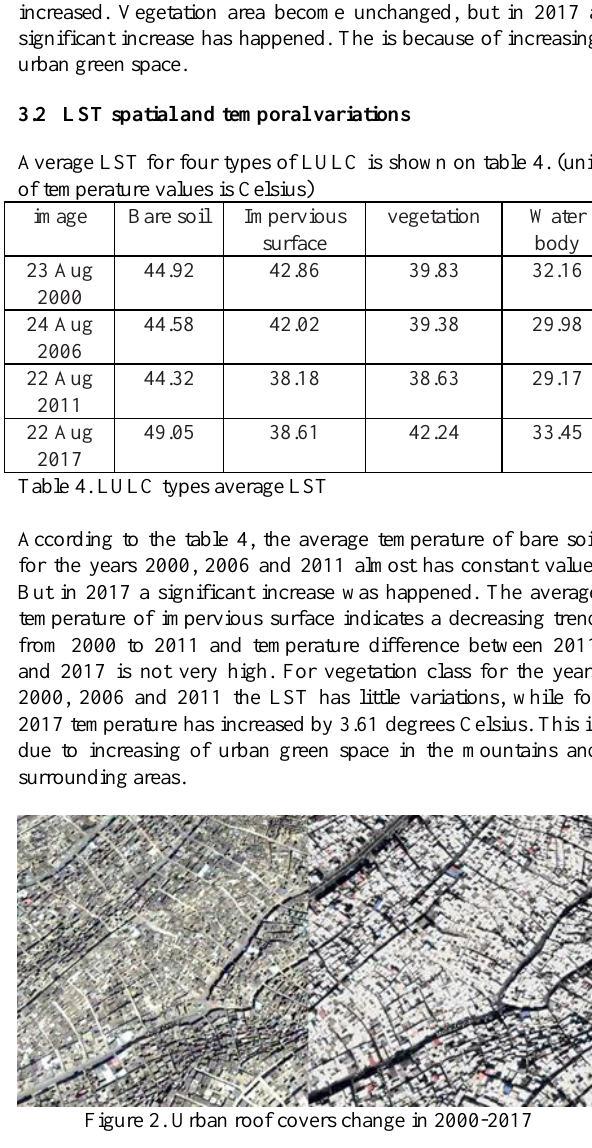
Table 3. Area of the LULC types during the 2000-2017